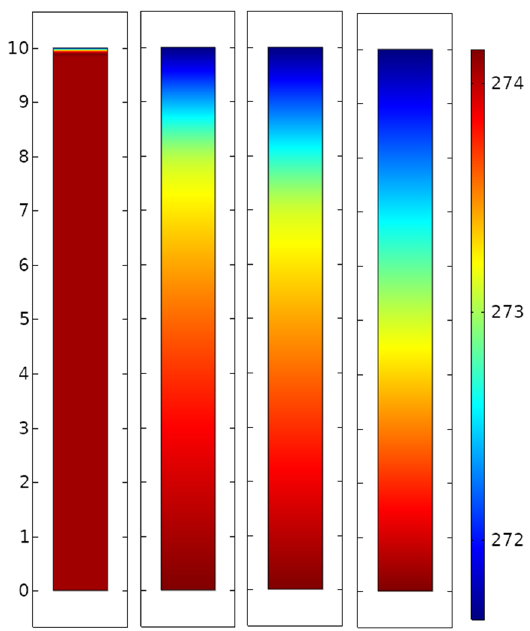
Figure 7. Temperature distribution at 0, 5, 10, and 35 h of case 2.